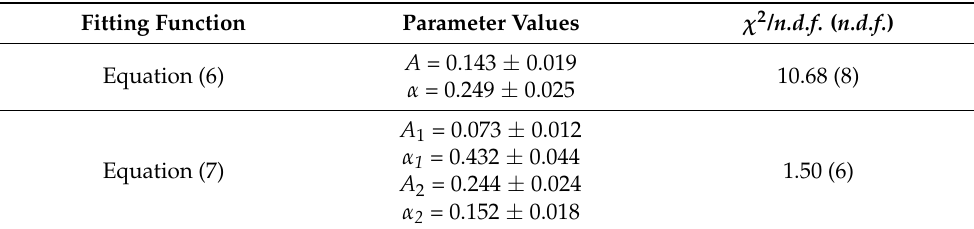
Table 4. The parameters of minimum χ 2 fits with the functions in Equations (6) and (7) of (cid:104) β T (cid:105) versus (cid:10) (cid:11) N part dependence in Figure 3b, obtained using consistent Tsallis function with transverse flow (Equation (5)). Fitting Function